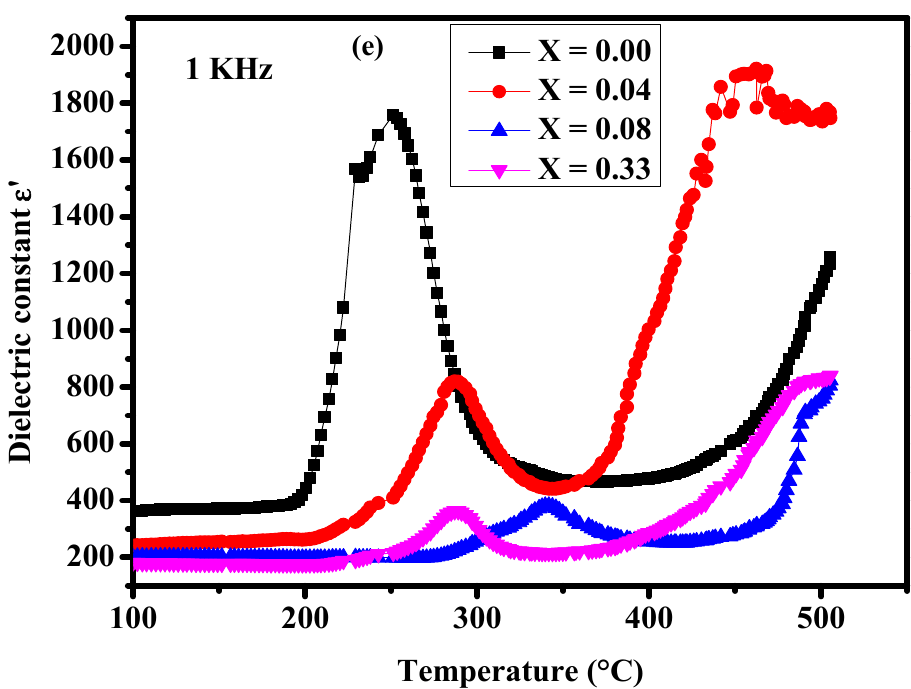
Figure 4. ( a – e ) Thermal evolution of ε r ′ at different frequencies and at different compositions for x = 0.00, 0.04, 0.08, and 0.33.